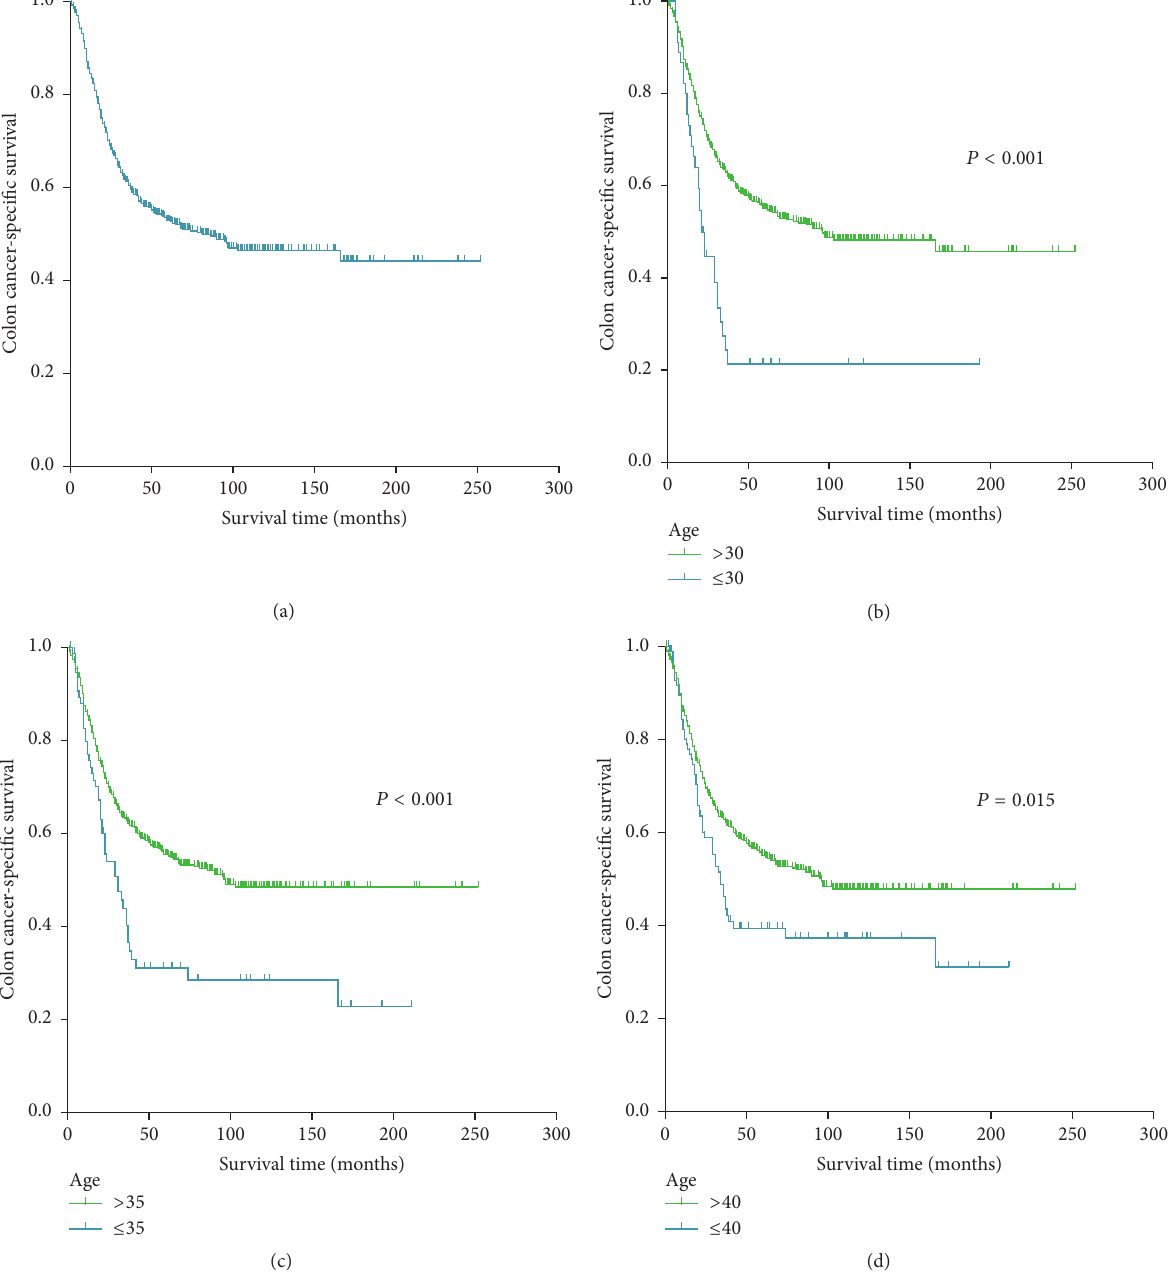
Figure 1: (a) The Kaplan-Meier survival curve for patients with nonmetastatic signet-ring cell carcinoma (SRCC) of the colon from the Surveillance,Epidemiology,andEndResults(SEER)cohort.Kaplan-MeiercurvesforpatientswithnonmetastaticSRCCofthecolonstratified by (b) 30 years of age, (c) 35 years of age, and (d) 40 years of